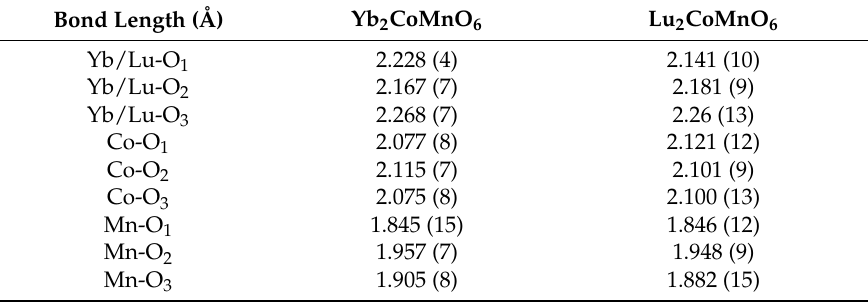
Table 2. Bond lengths for YCMO and